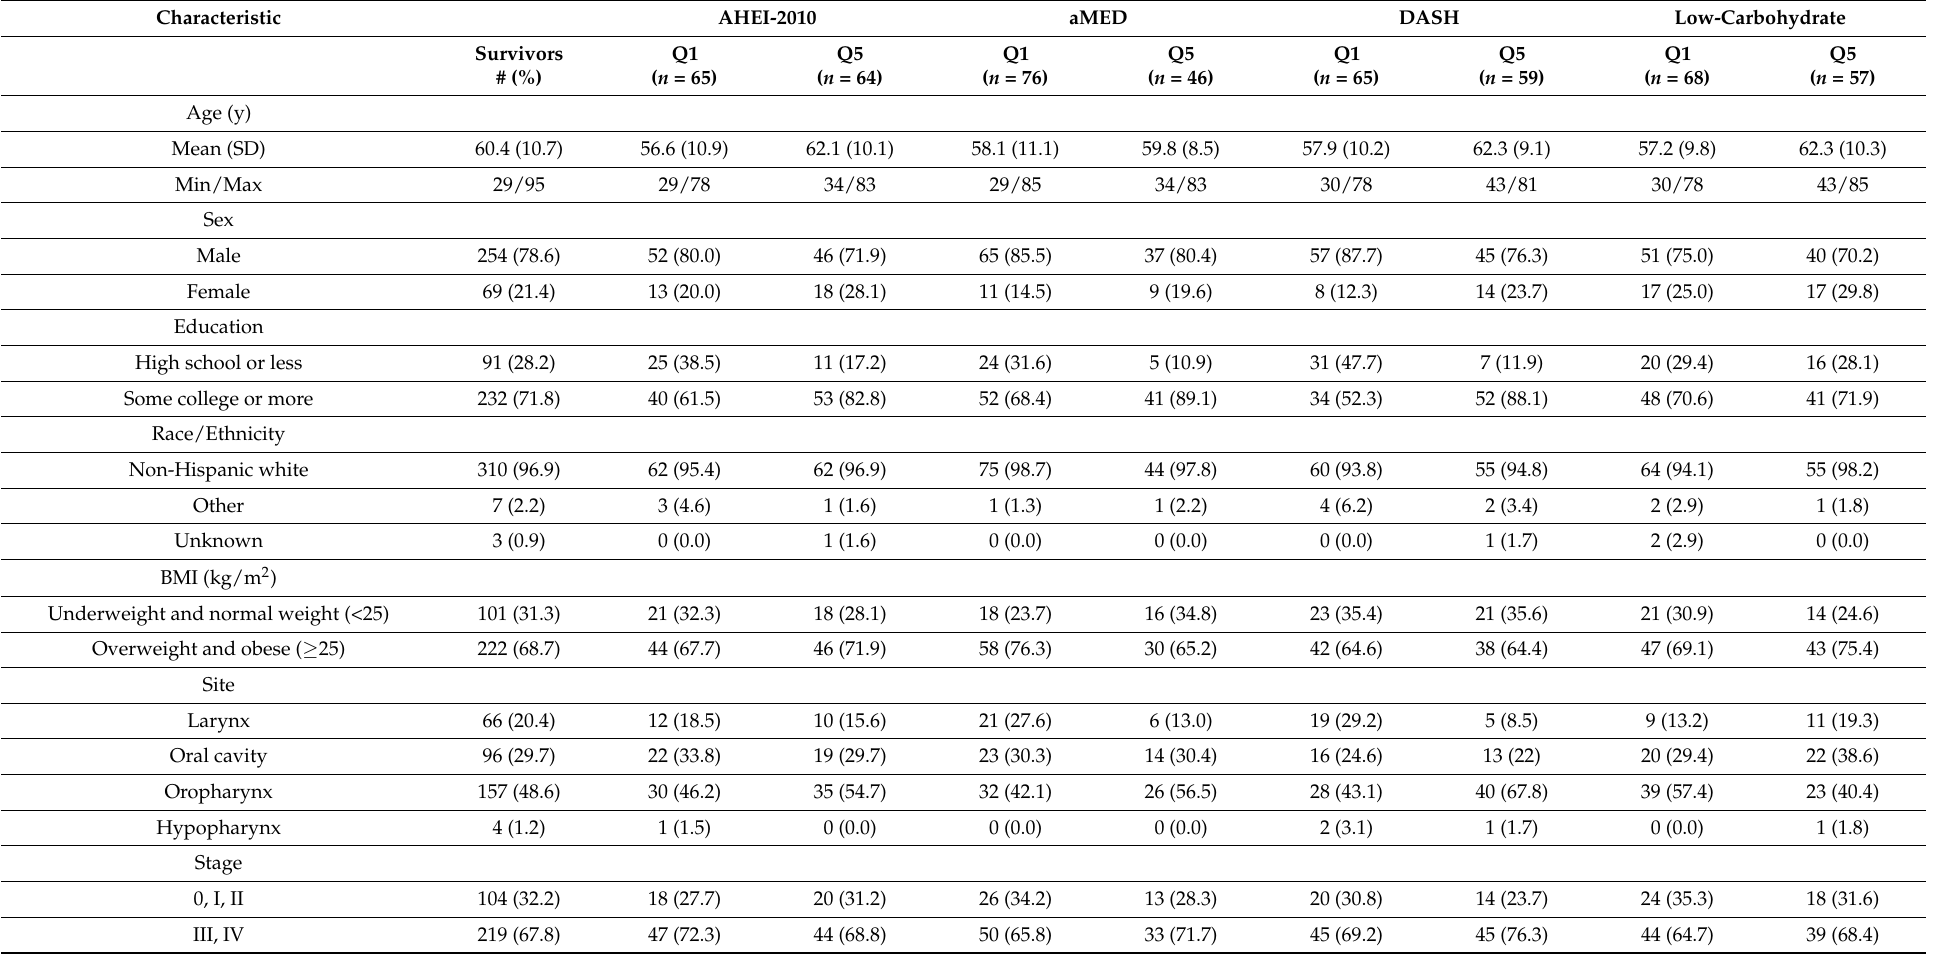
Table 1. Demographic, clinical, and behavioral characteristics of the study participants ( n =